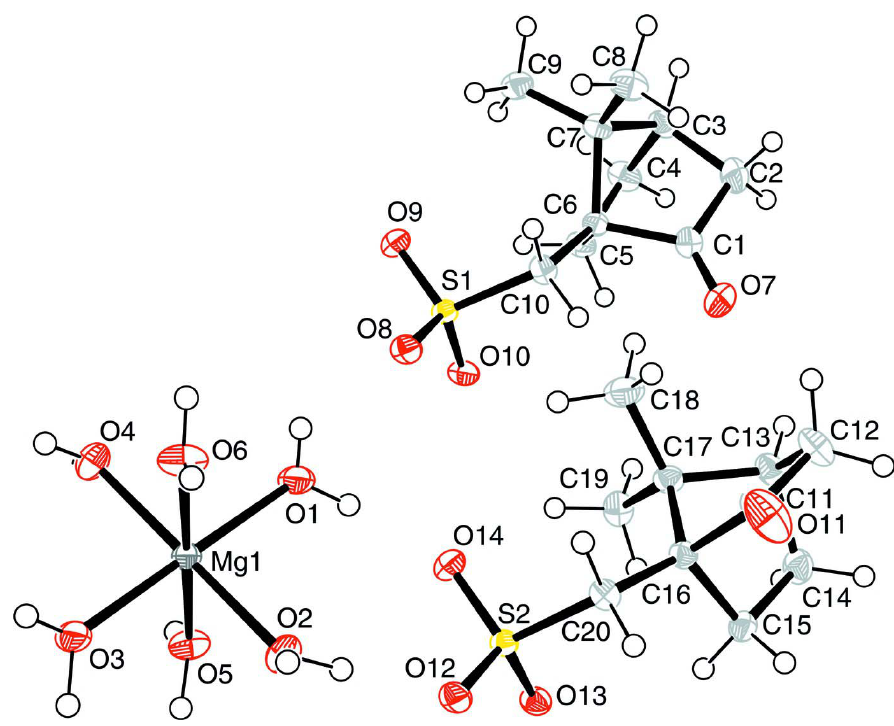
Figure 2 ORTEP representation of [Mg(H atoms are shown as small spheres of arbitrary